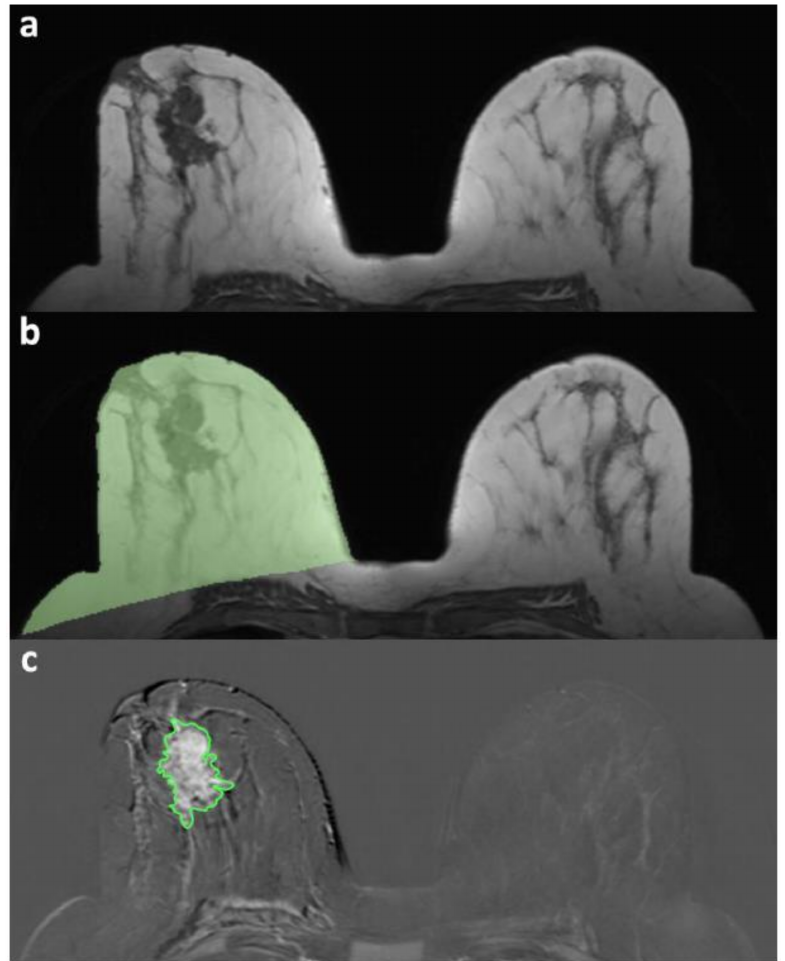
Figure 1. Example of a segmentation procedure for breast magnetic resonance volume metrics. ( a ) Definition of the slice with the largest breast area. ( b ) Whole breast volume segmentation with the region-growing method (green area); ( c ) fully manual segmentation of the tumour volume (green-contoured